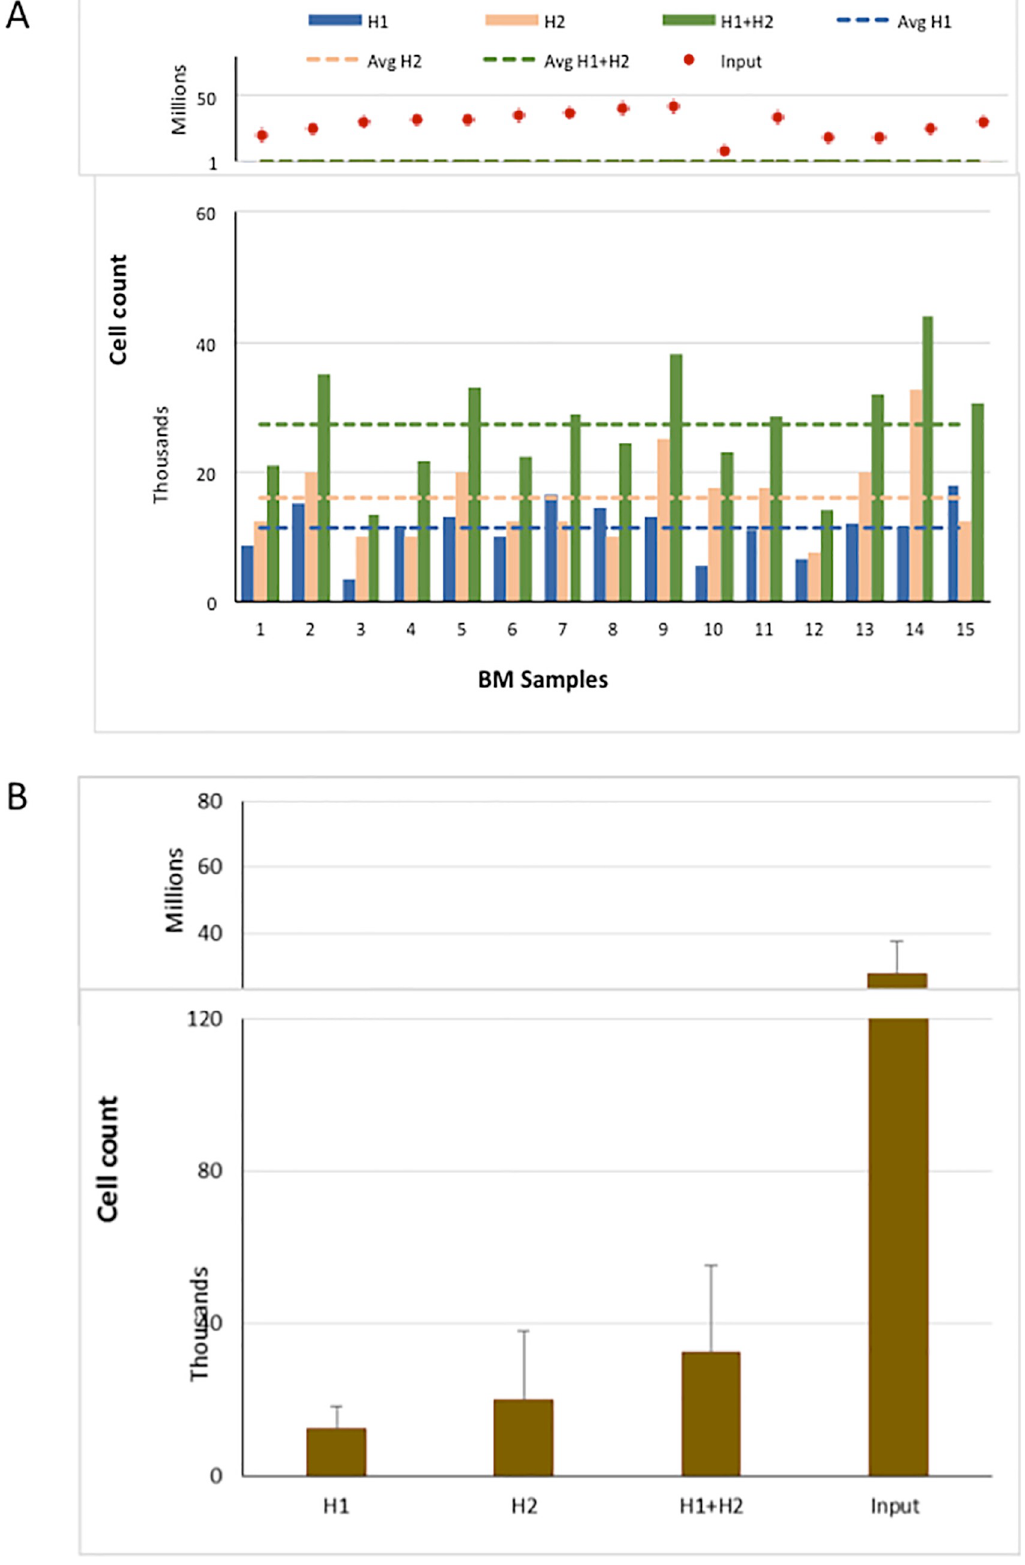
Fig 2. Yield of nucleated BM cells using the Parsortix system. https://doi.org/10.1371/journal.pone.0246139.g002 PLOS ONE | https://doi.org/10.1371/journal.pone.0246139 May 14,